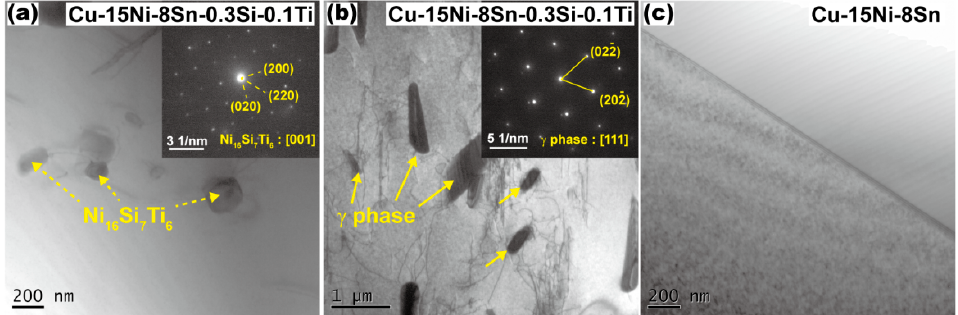
dotted line), whose average major axis, minor axis, and aspect ratio are about 617 nm, 225 nm, and 2.8, respectively. Figure 4. TEM images revealing the microstructures of Cu-15Ni-8Sn-0.3Si-0.1Ti ( a ) and Cu-15Ni- 8Sn alloys ( b , c ) after annealing at 1093 K for 1 h. The inserts reveal the selected area diffraction patterns (SADP) of related particles.